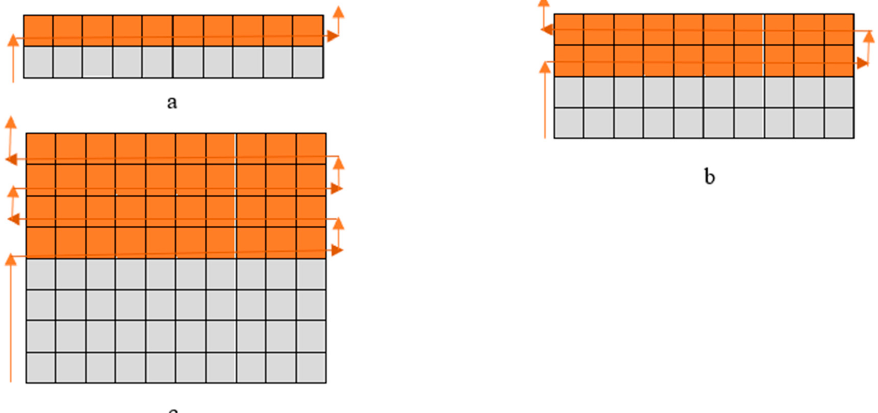
Figure 1. Images and principle scheme of conductive yarn layout on the technical back side of a specimen ( —courses with conductive yarn,